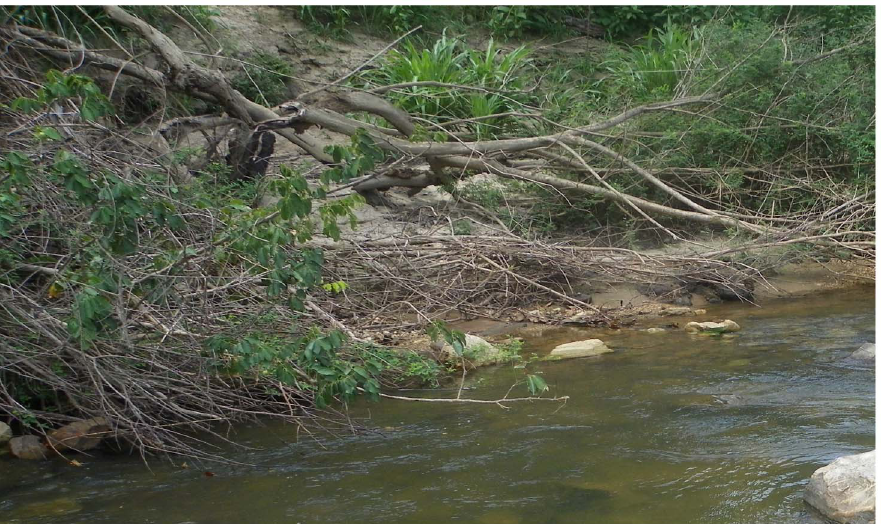
Figure 6. S.damnosum s.l. aquatic habitat not predicted by the BRR model. The photo illustrates the hanging vegetation immersed in fast flowing water characteristic of the two breeding sites in the Achwa River not predicted by the BRR model.